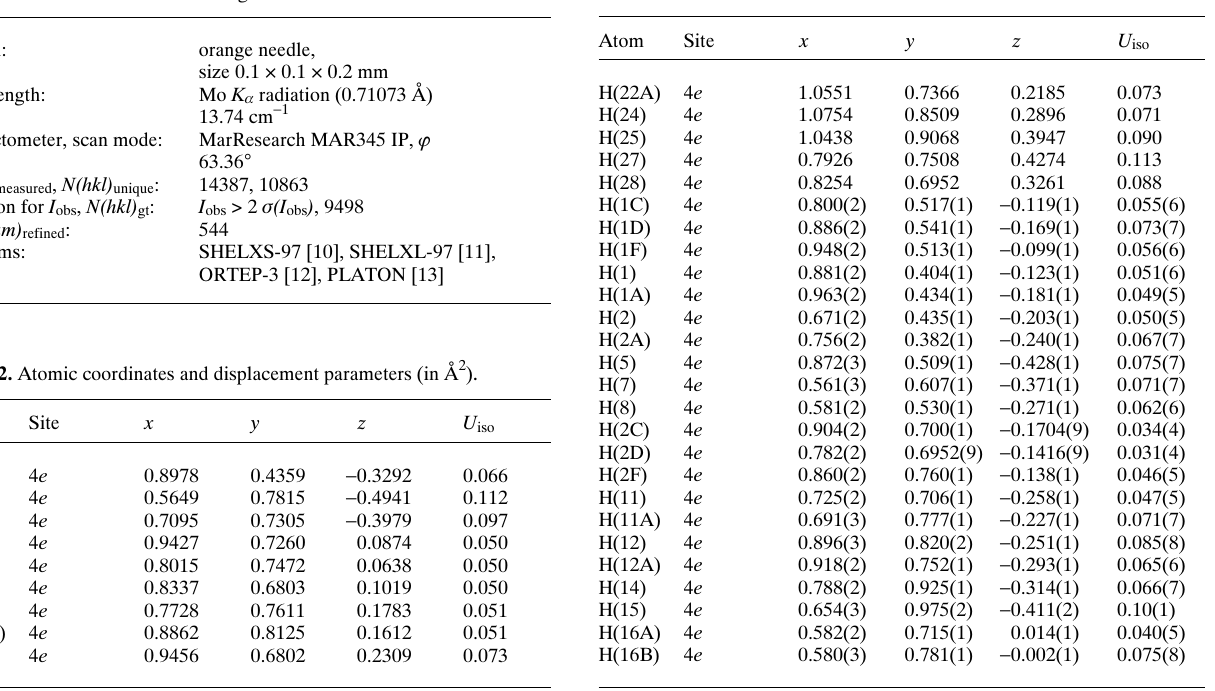
Table 1. Data collection and